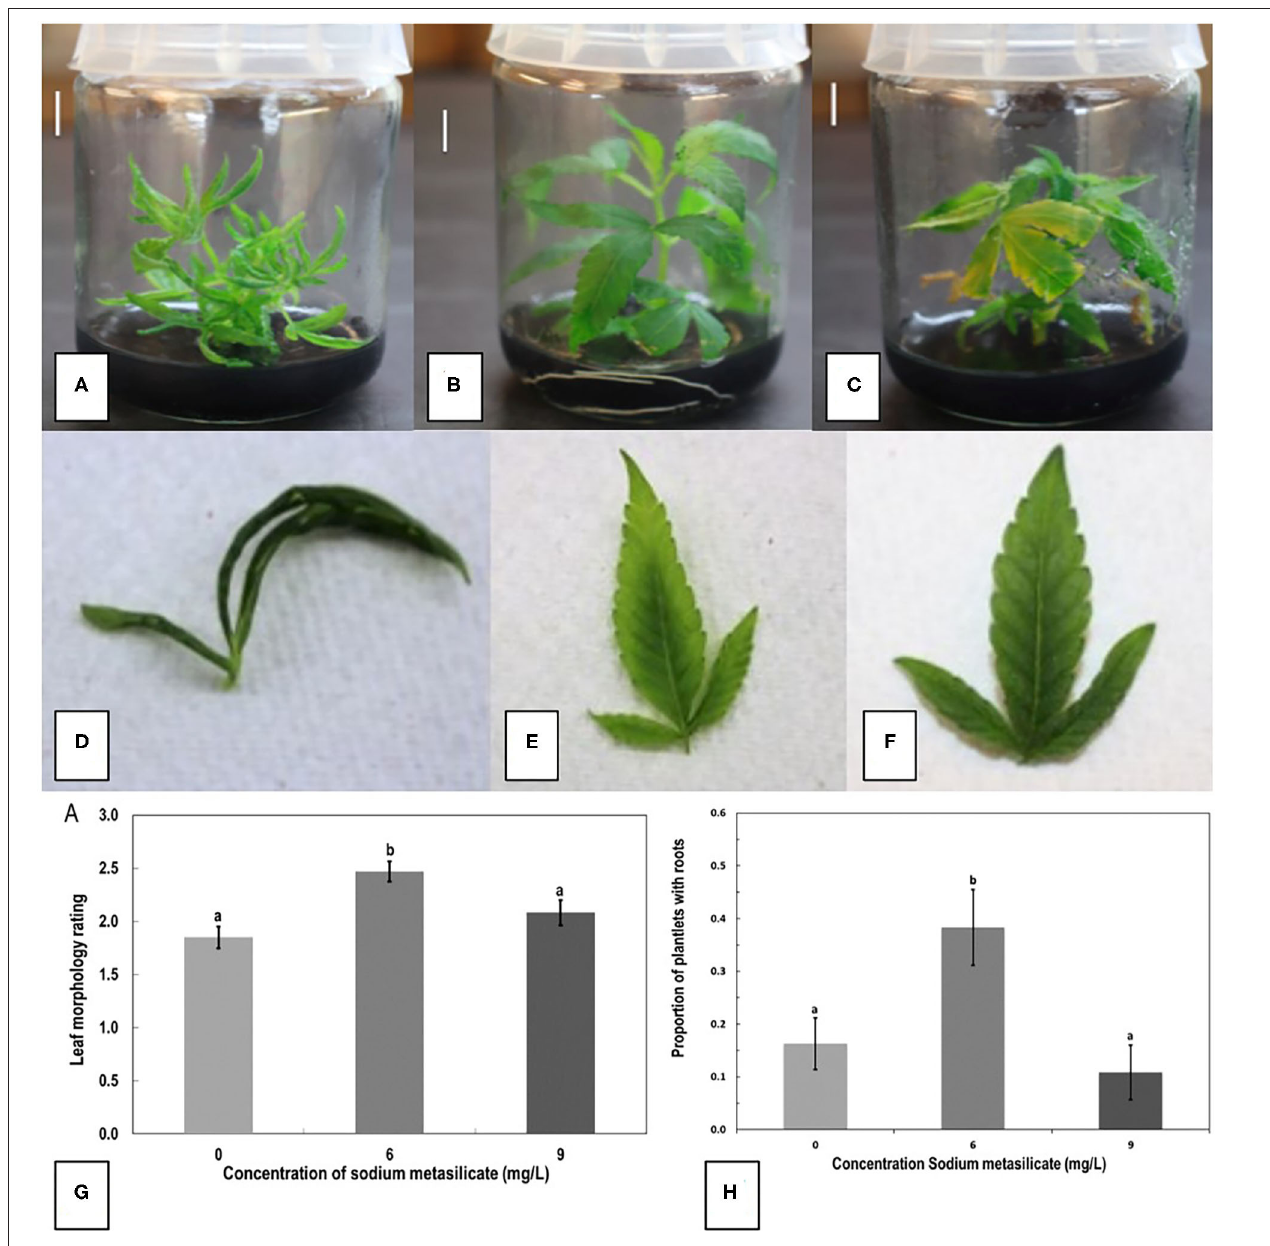
FIGURE 6 | The effect of sodium metasilicate at 0 (A) , 6 (B) , and 9 (C) mg/L in the MM on shoot growth of genotype MBD from nodal segments. Optimal growth and rooting can be seen on 6 mg/L. (D–F) Leaf morphology rating scale applied to plantlets during growth in tissue culture as an indication of plantlet health. (D) A rating of 1 shows thin curled leaves, light green in color. (E) A rating of 2 shows leaves light green in color with some curling. (F) A rating of 3 shows dark green, flat leaves with serrated margins. (G) Average leaf morphology rating after 4 weeks of growth on MM with added sodium metasilicate. (H) Proportion of plantlets that developed roots on MM supplemented with sodium metasilicate at 6 mg/L was significantly different to the proportion of roots that developed from plantlets on MM, MM + sodium metasilicate 9 mg/L, and MMC. Bars followed by different letters indicate significant differences.